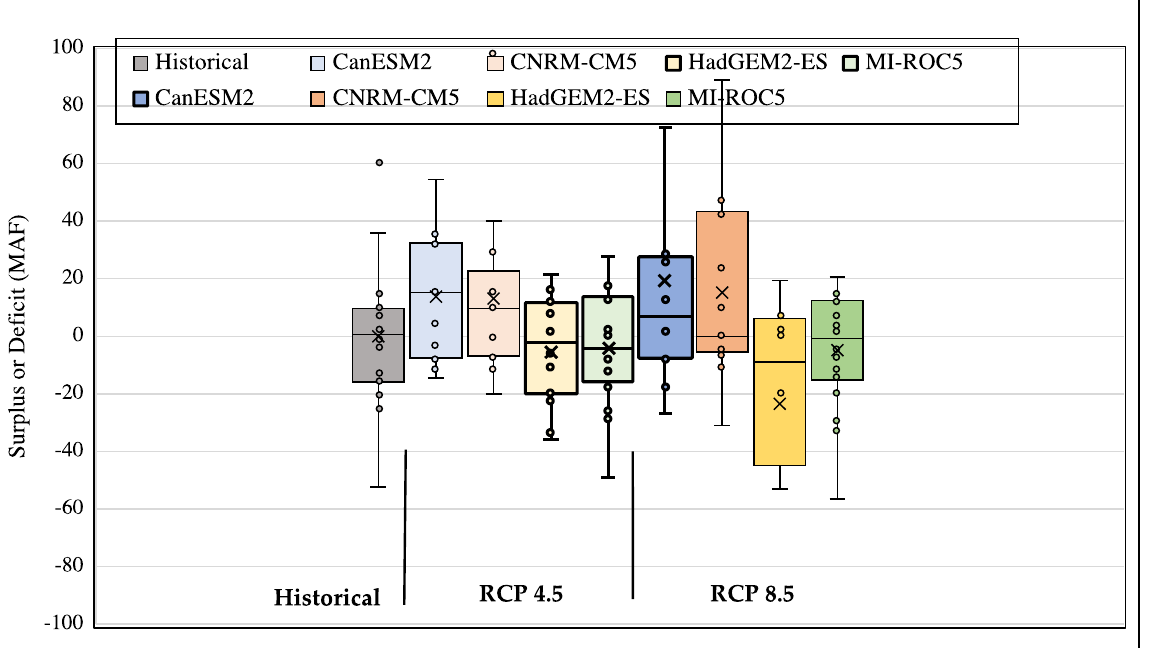
Figure 4. Boxplot of cumulative deficit and surplus (MAF) for all years and all RCP 4.5 and 8.5 scenarios and all models (CanESM2, CnRM-CM5, HadGEM2-ES, MI-ROC5) at Lees Ferry. (Note: 1 MAF = 1233 million cubic m).